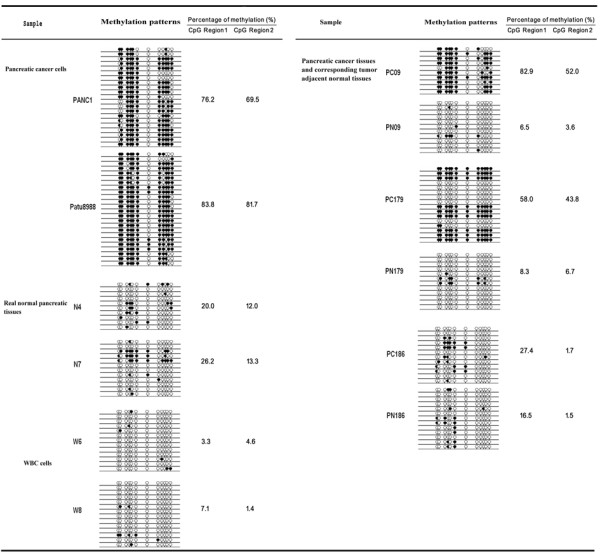
Methylation status of 12 CpG island sites and the methylation level of CpG Region 1 and CpG Region 2 in the samples determined using BSP cloning-based sequencing analysis. BSP cloning-based sequencing analysis was performed on real normal pancreatic tissues (N4 and N7), white blood cells (W6 and W8) of two healthy volunteers, pancreatic cancer cell lines (PANC1 and Patu8988), pancreatic cancer tissues (PC09, PC179, and PC186), and the corresponding adjacent normal tissues (PN09, PN179, and PN186). Black dot, methylated; white dot, unmethylated.